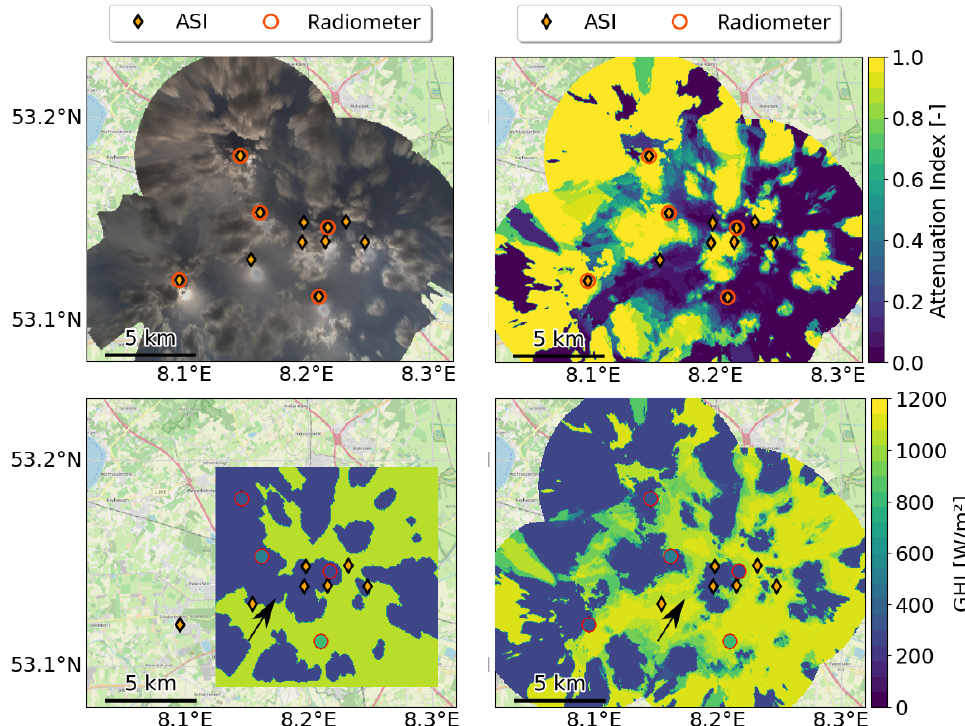
Figure 8. This figure shows an exemplary scattered, single cloud layer situation over Olden- burg on 5 June 2020 10:22:00. The panels show stitched raw, undistorted and georeferenced all- sky imager (ASI) images ( top, left ), the map of attenuation index derived from the ASI network ( top, right ), the GHI map derived by the ASI pair ( bottom, left ) and the GHI map derived by the ASI network ( bottom, right ). The GHI maps also show readings of the radiometer stations (red circles) by markers which are color coded as indicated by the color bar. Note that the sun posi- tion causes a shift of cloud observations in northeastern direction between the figures in the top row and bottom row. (background: © OpenStreetMap contributors 2022. Distributed under